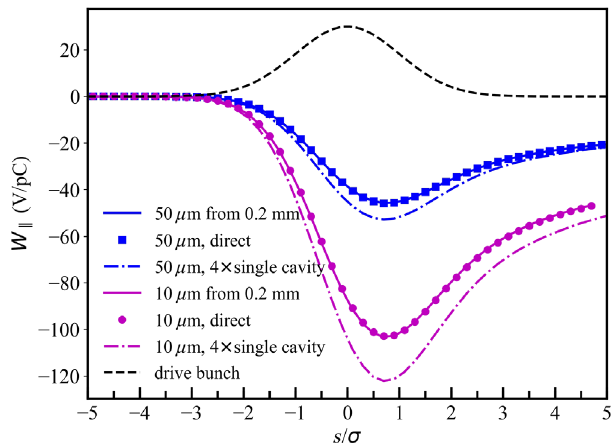
FIG. 8. Comparison of the reconstructed longitudinal wake potential (solid lines) due to various σ (indicated in legend) with direct simulation for the four-cavity structure (symbols). The dash-dotted lines show four times the wake potential for a single cavity at the indicated bunch length.